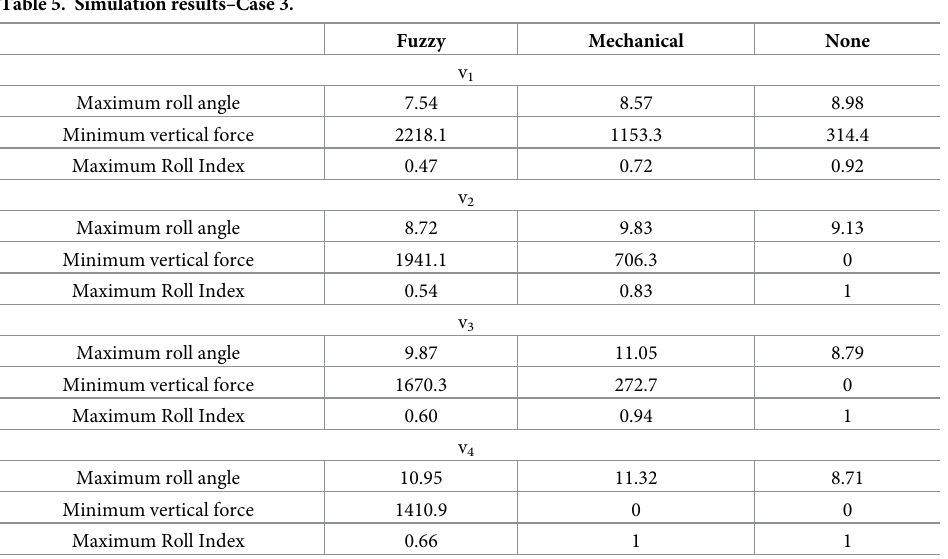
Table 5. Simulation results–Case 3.